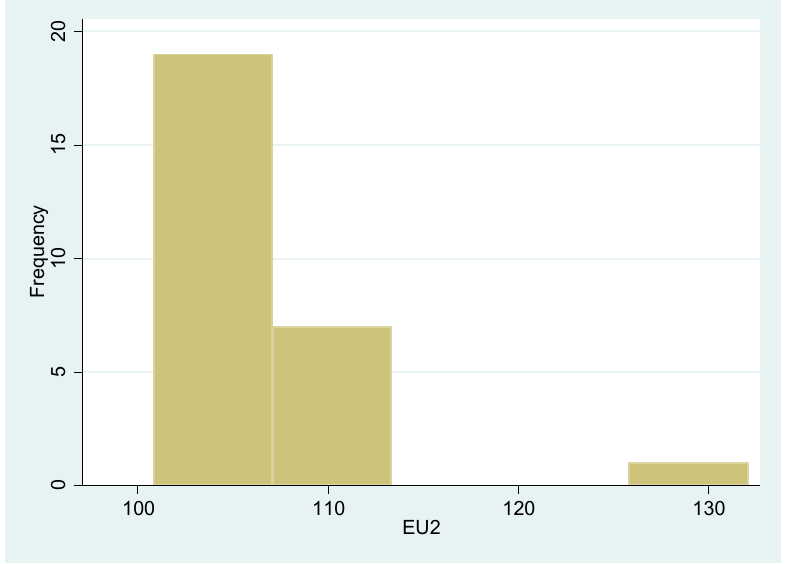
Figure 1. Frequency of the average growth rate of the share of renewable energy consumption in the EU, 2000–2019.